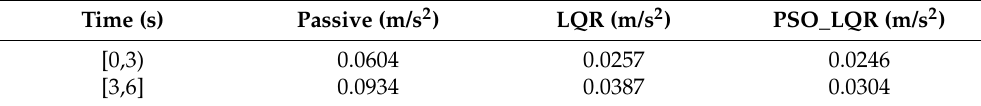
Table 7. RMS comparison of BA of three groups of test data.